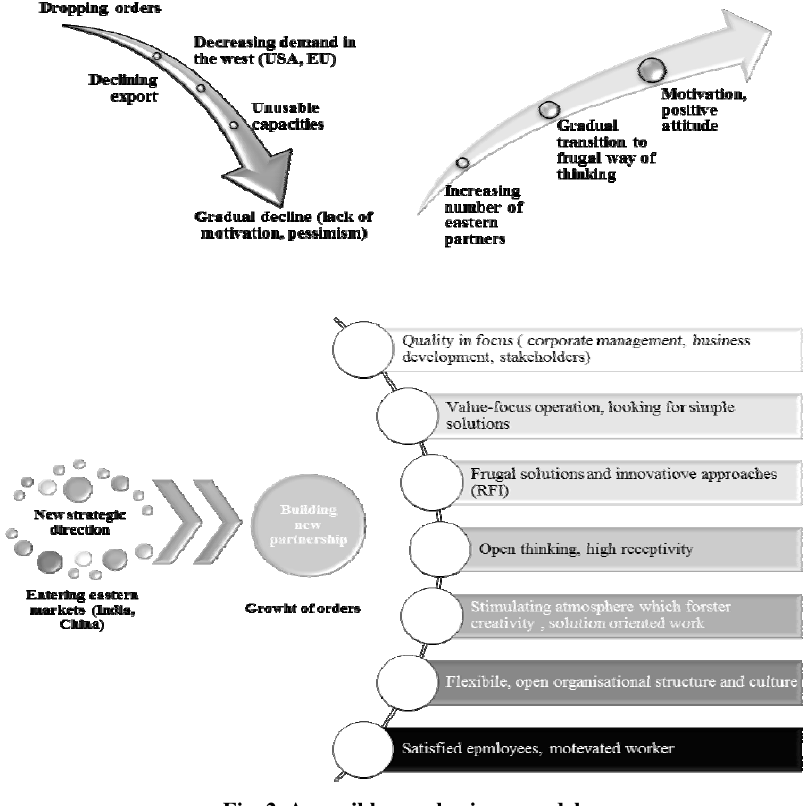
Fig. 2. A possible new business